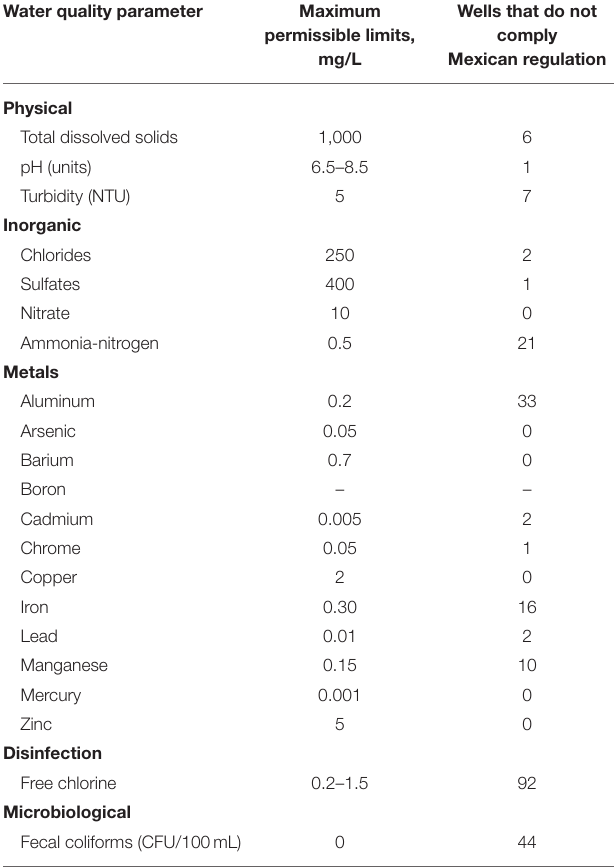
TABLE 2 | Summary of the results of groundwater quality information from wells located in Mexico City according to the Maximum Permissible Limits of NOM-127-SSA1-1994 (DOF,